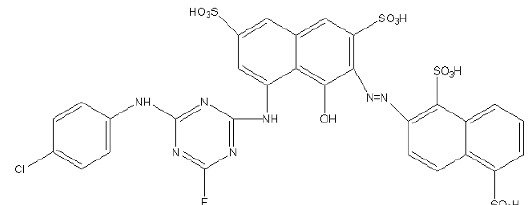
Figure 1. Reactive Red 184 (Cibacronrot